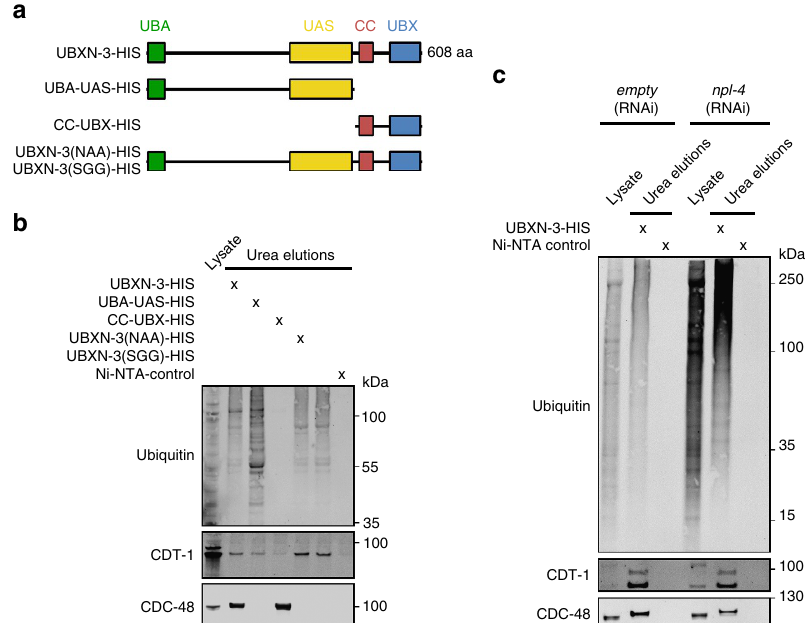
Figure 5 | Functional analysis of UBXN-3-binding domains. ( a ) Schematic illustration of full-length UBXN-3, truncated peptides and FPK-motif mutants used for binding studies. Full-length UBXN-3b consists of 608 amino acids (aa). ( b , c ) wt or NPL-4-depleted worm lysates were incubated with the indicated, recombinant UBXN-3 variants coupled to Ni-NTA beads and analysed by western blotting. Eluted proteins were detected by immunolabeling of ubiquitin conjugates (FK2), CDT-1 and